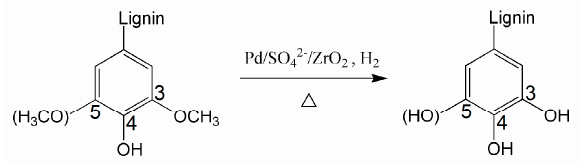
Figure S1: The 1H-NMR spectra of lignin samples before (a, L0) and after (b, L4) the reaction, Table S1: The e ff ects of reaction conditions on the degradation